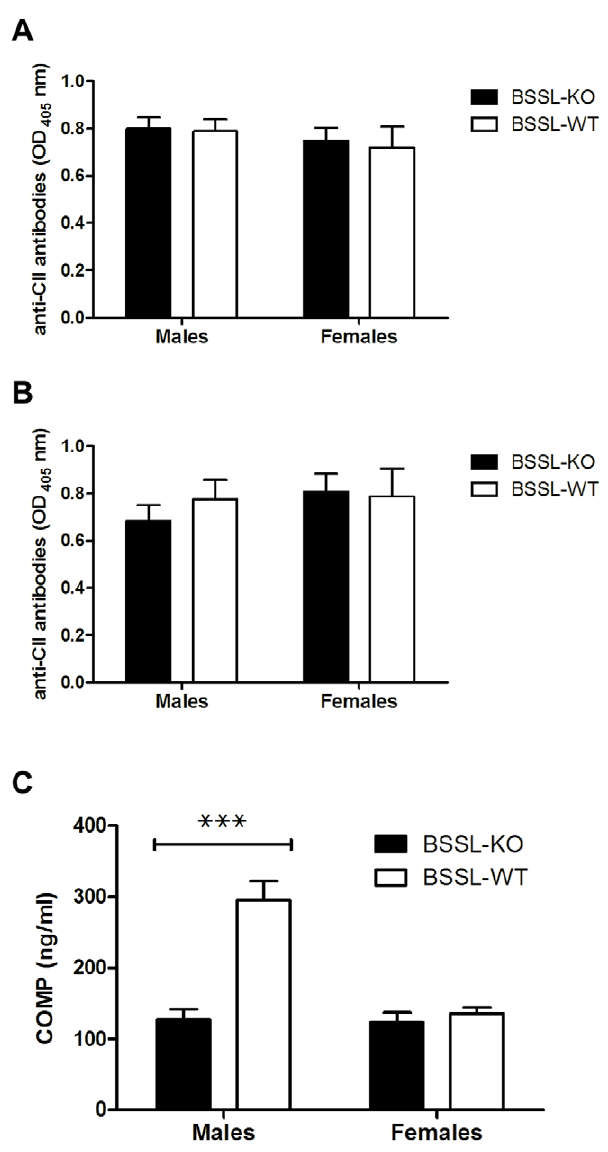
Figure 2. Development of IgG anti-CII antibodies and cartilage degradation in BSSL-KO and BSSL-WT mice. Littermates of BSSL- KO and BSSL-WT mice were immunized with rat CII on day 0 and boosted on day 21 to induce arthritis. The concentration of IgG anti-CII antibody in plasma was determined by ELISA at (A) day 30 and (B) day 57 after initial injection with rat CII. As a marker of cartilage degradation, the concentration of cartilage oligomeric matrix protein (COMP) present in mouse plasma was determined by ELISA (C) on day 57 after initial injection with rat CII. Values are expressed as mean 6 SEM. ??? =p ,